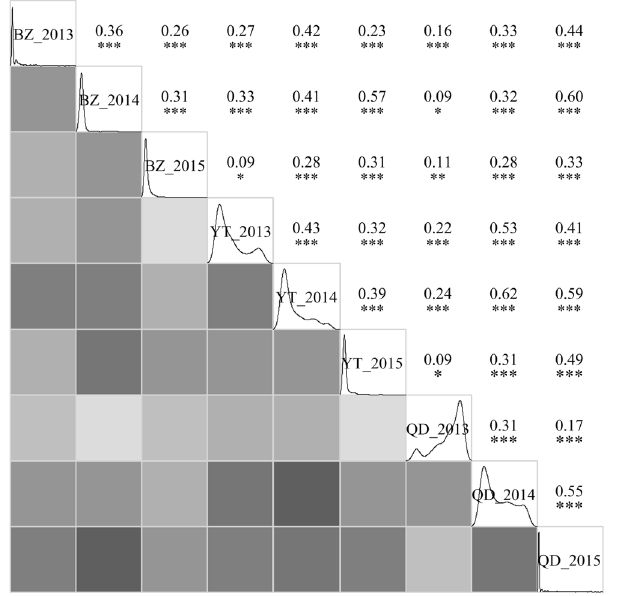
Figure 2. Pairwise correlations of SR between nine different field experiments at three locations and in three growing seasons. The density curves of SR were showed in the diagonal panels, and the correlations were showed both in shade map in the lower left panels and correlation matrices with significance in the upper right panels. The darker the colors are in the shade map, the stronger the relationships between different experiments. * P < 0.05; ** P < 0.01; *** P < 0.001.